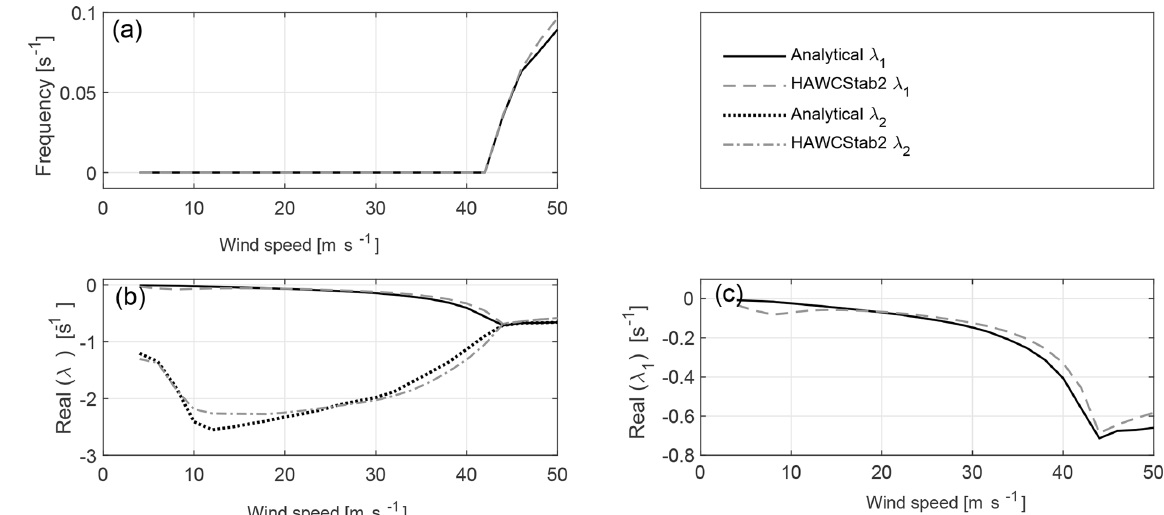
Figure 10. Comparison of the frequency (a) , the real part of the two eigenvalues (b) and a zoom into the first eigenvalue (c) of the yaw mode for the 2-DOF model from the analytic solution, and the imitation in